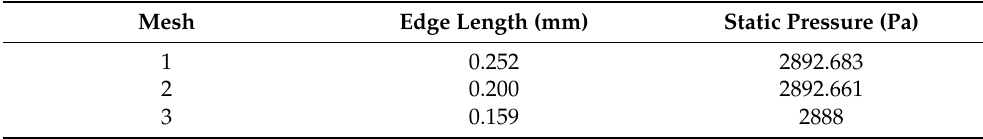
Table A1. Grid independence study using Richardson’s extrapolation. Meshes change from coarsest to finest with the numer of elements doubling at each step. Pressure values are extracted at the centre of the